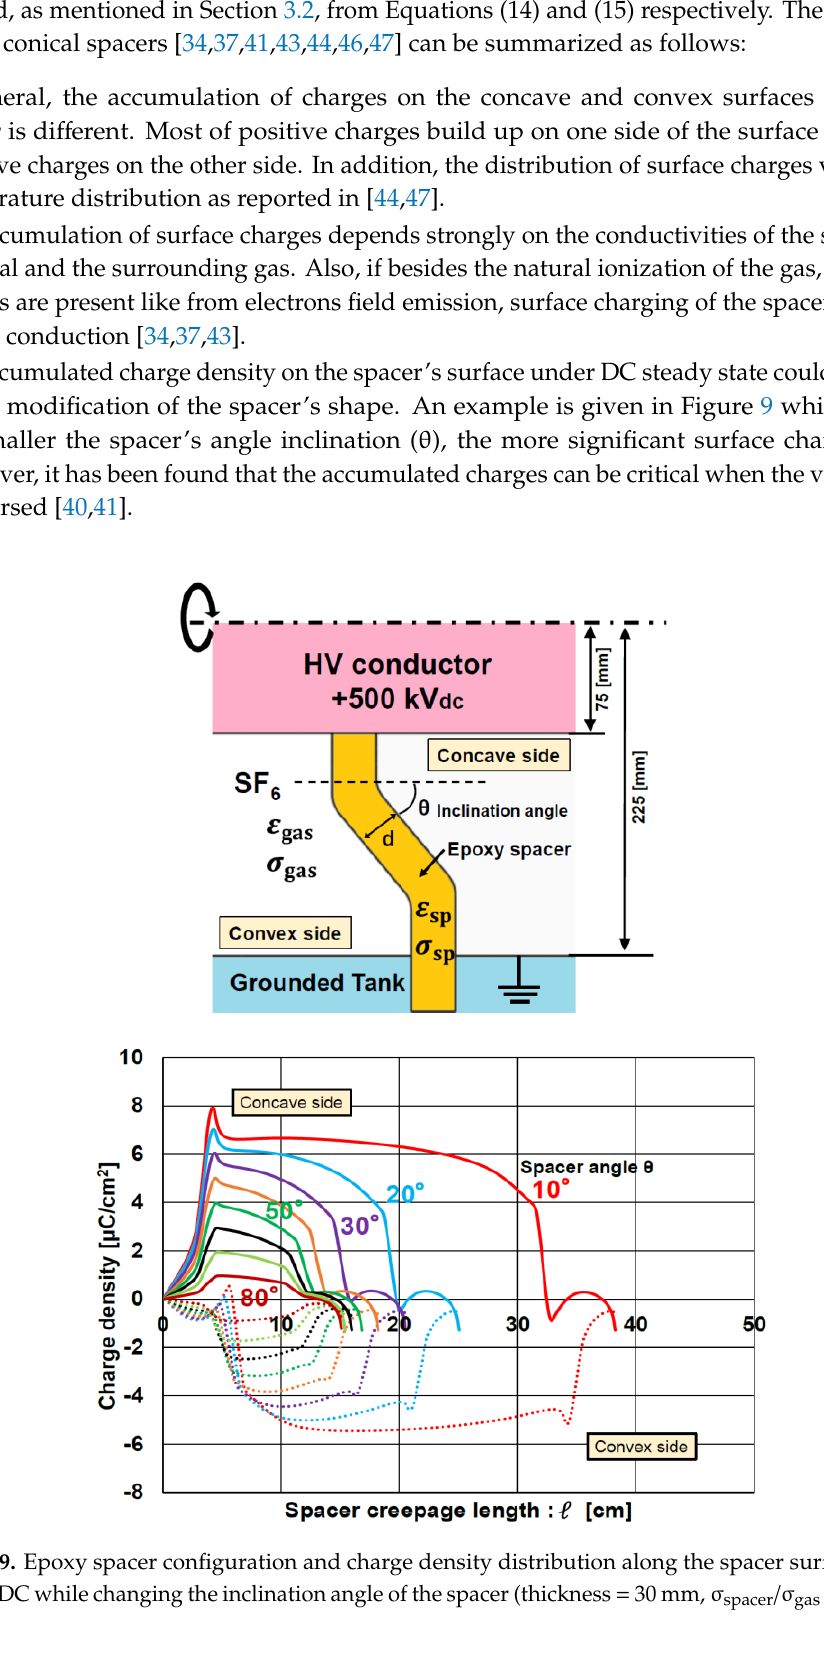
Figure 8. Graphs of the electric conductivity of MFF filled epoxy and the resulting electric field distribution along the insulator’s surface. ( a ) Measured bulk conductivity at three different temperatures (30 °C, 60 °C and 100 °C). ( b ) Normalized tangential electric field distribution E tang at the insulator’s surface made of MFF filled epoxy under 500 kV DC for constant temperature (30 °C) and gradient temperature compared to conventional epoxy material σ (30 °C) = 10 −13 S/m [43].